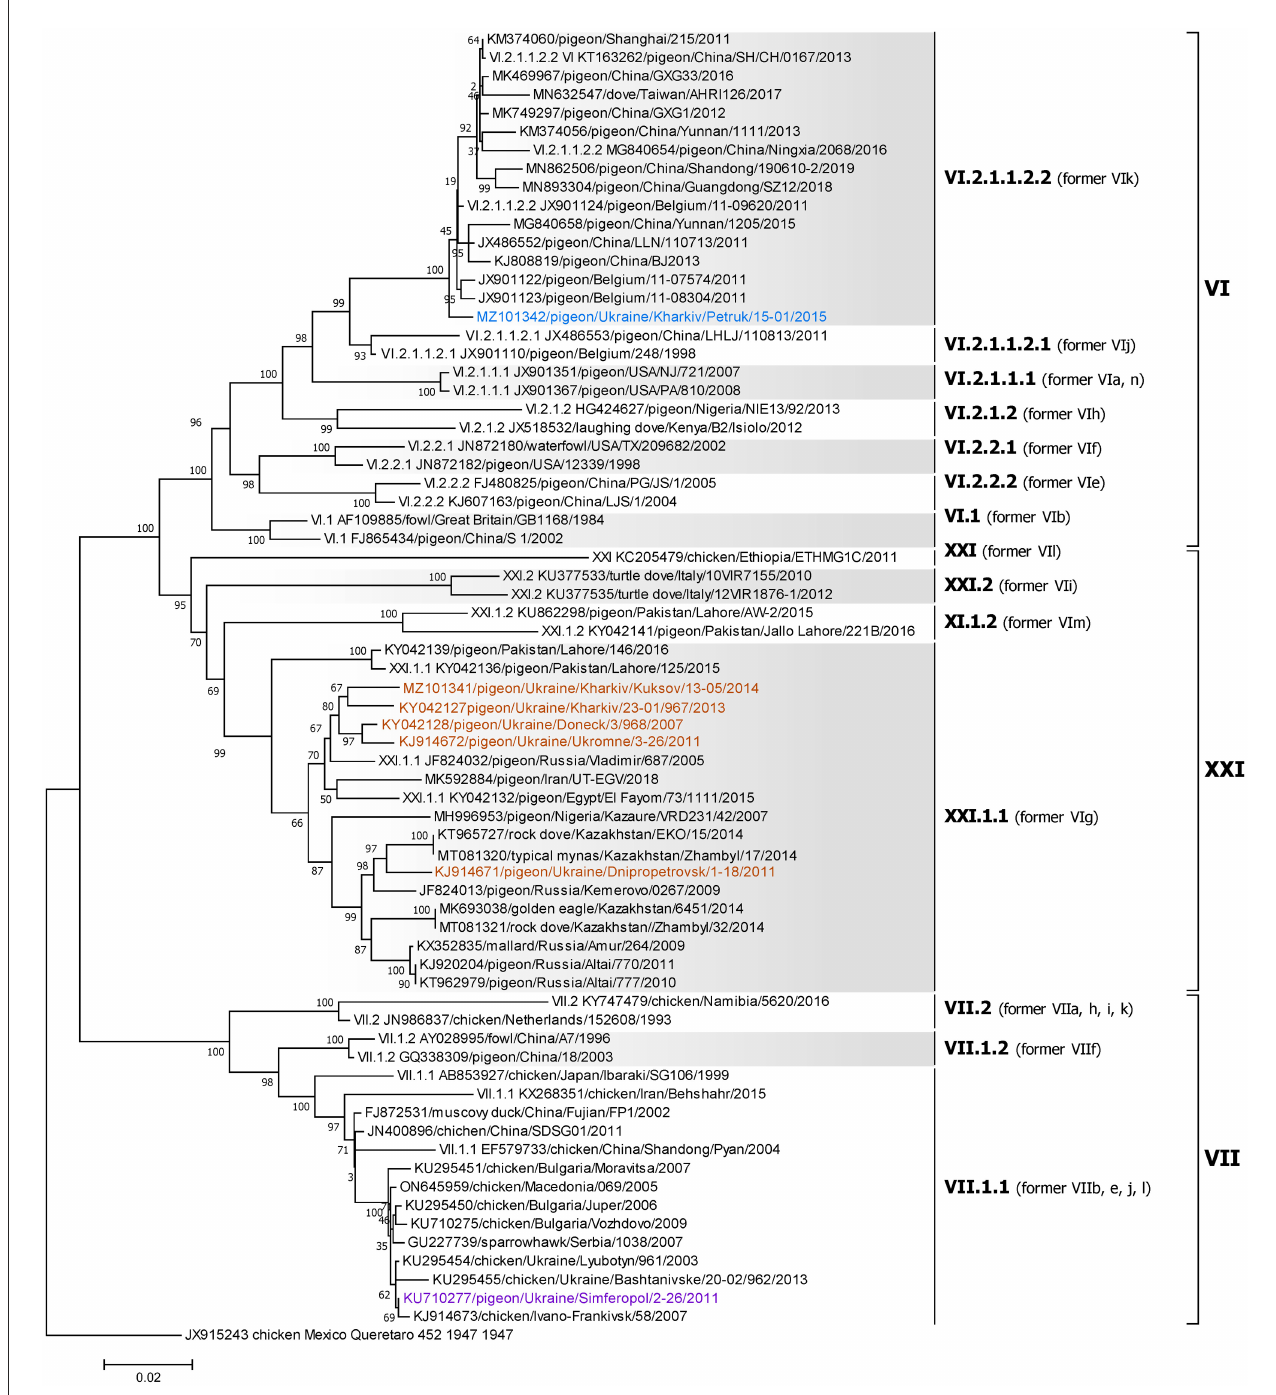
FIGURE5 Phylogenetic analysis of NDV genotype VI, VII, and XXI class II isolates based on the complete fusion gene sequences constructed with the maximum likelihood method with 1,000 bootstrap replicates. The analysis involved 71 nucleotide sequences (a sequence from genotype XVI JX915243/chicken/Mexico/Queretaro/452/1947 was included as an outgroup). All positions containing gaps and missing data were eliminated. There were a total of 1,660 positions in the final data set. The isolates used in this study are shown in blue (genotype VI), purple (genotype VII), and brown (genotype XXI). The Roman numerals on the right of the phylogenetic tree represent the respective sub-genotype for each isolate in accordance with the current classification (5) and the former nomenclature (58) is listed in parenthesis for